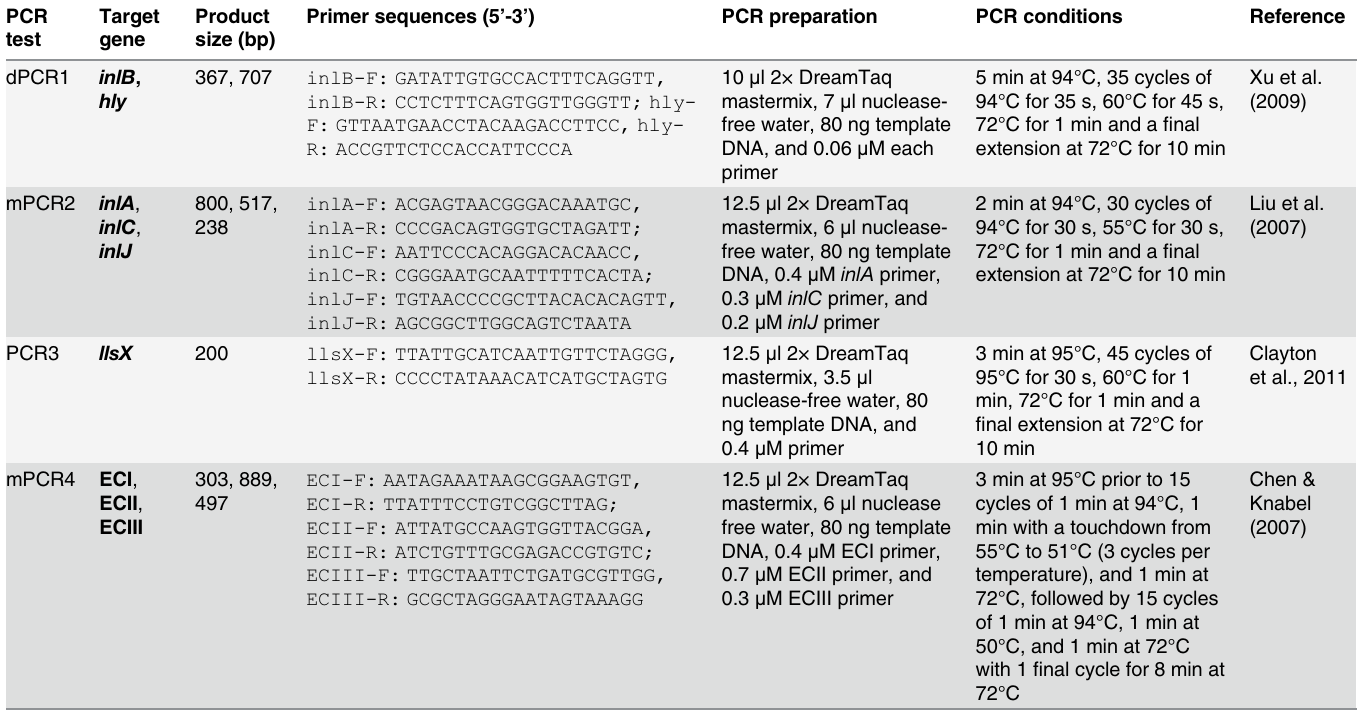
Table 1. Primer sequences, PCR preparations and PCR conditions used for L . monocytogenes isolates in this